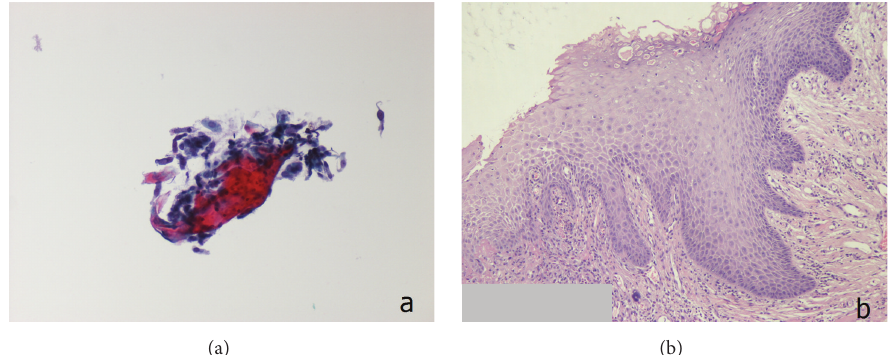
Figure 1: (a) Cytology-squamous cells (ThinPrep; Pap stain × 400). (b) Histology-hyperplastic squamous epithelium; Haematoxylin & Eosin × 200.